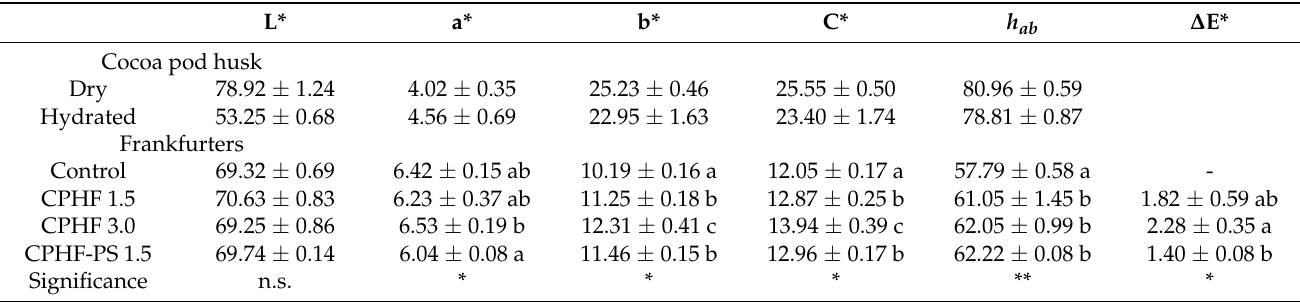
Table 3. Color parameters of cocoa pods husk and